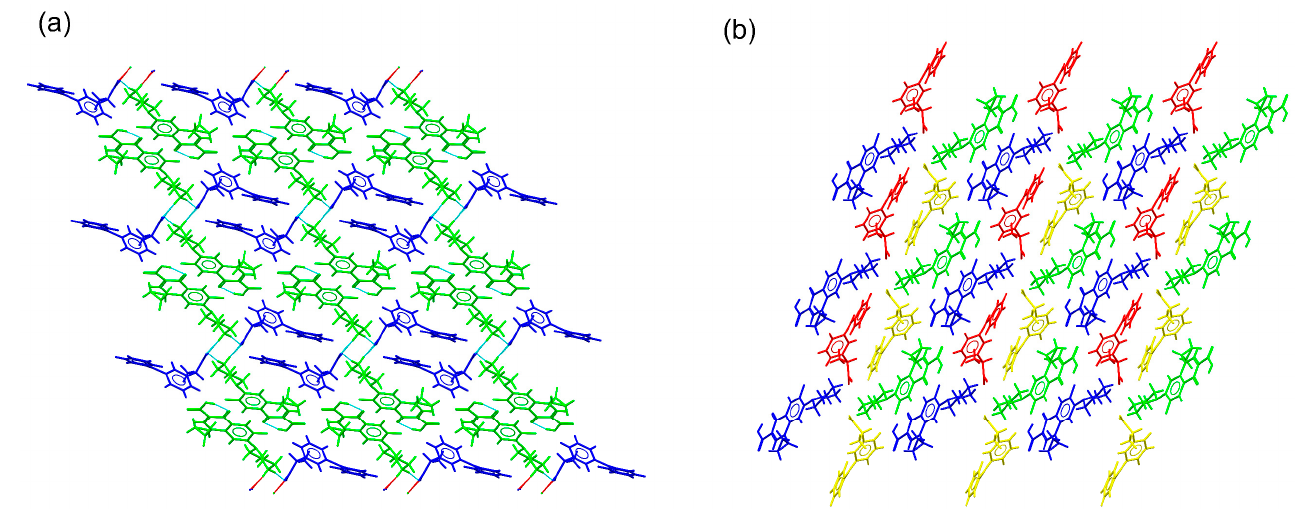
Figure 8. Detailed view of the packing arrangements for ( a ) CIP–KET (CIP cations in green, KET anions in blue) and ( b ) CIP–DKT (CIP cations in green and blue, DKT anions in red and yellow).